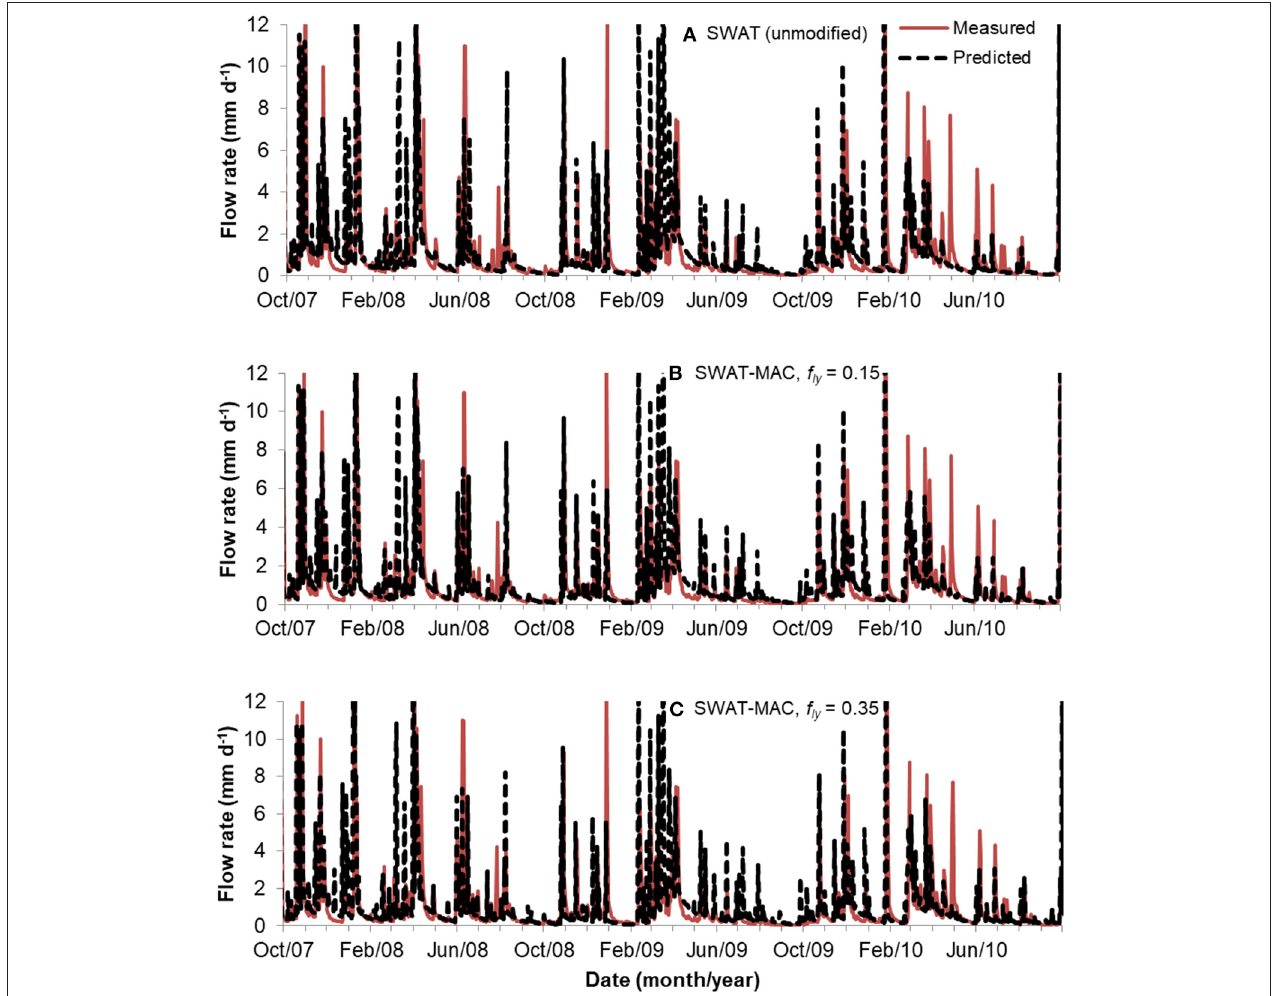
FIGURE 2 | Simulated stream flow rates with (A) unmodified SWAT, (B) SWAT-MAC using 0.15 as the macropore connectivity factor ( f ly ), and (C) SWAT-MAC using f ly = 0.35. Flow rate is truncated at 12mm d − 1 so peaks < 5mm d − 1 are